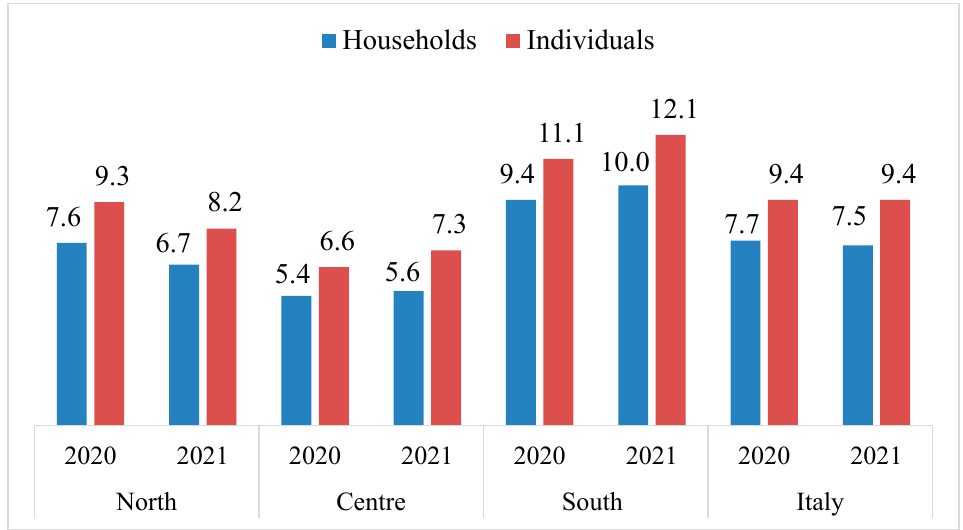
Figure 1. Poverty rate trends in Italy, 2005–2021. Source: own elaboration on the Istat database. From 2020, the poverty rate decreased by 0.2 percentage points for individuals and kept the same percentage for households. The rate in southern Italy increased from 9.4% to 10% for individuals and from 11.1% to 12.1% for households. The latter are the largest poverty values in Italy (Figure 2).